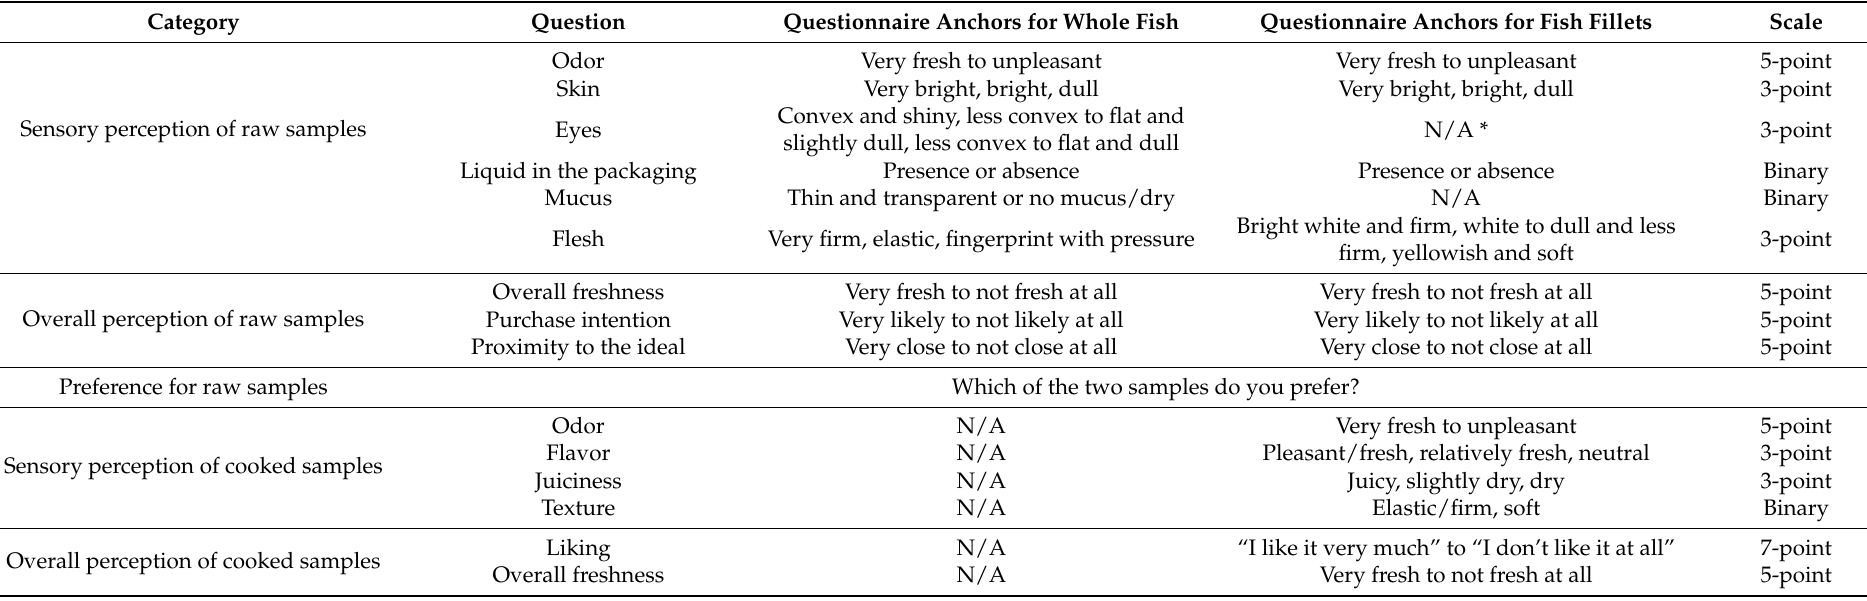
Table 1. Questions asked in the consumer study for the whole fish and the fish fillets. Anchors and type of scale are also